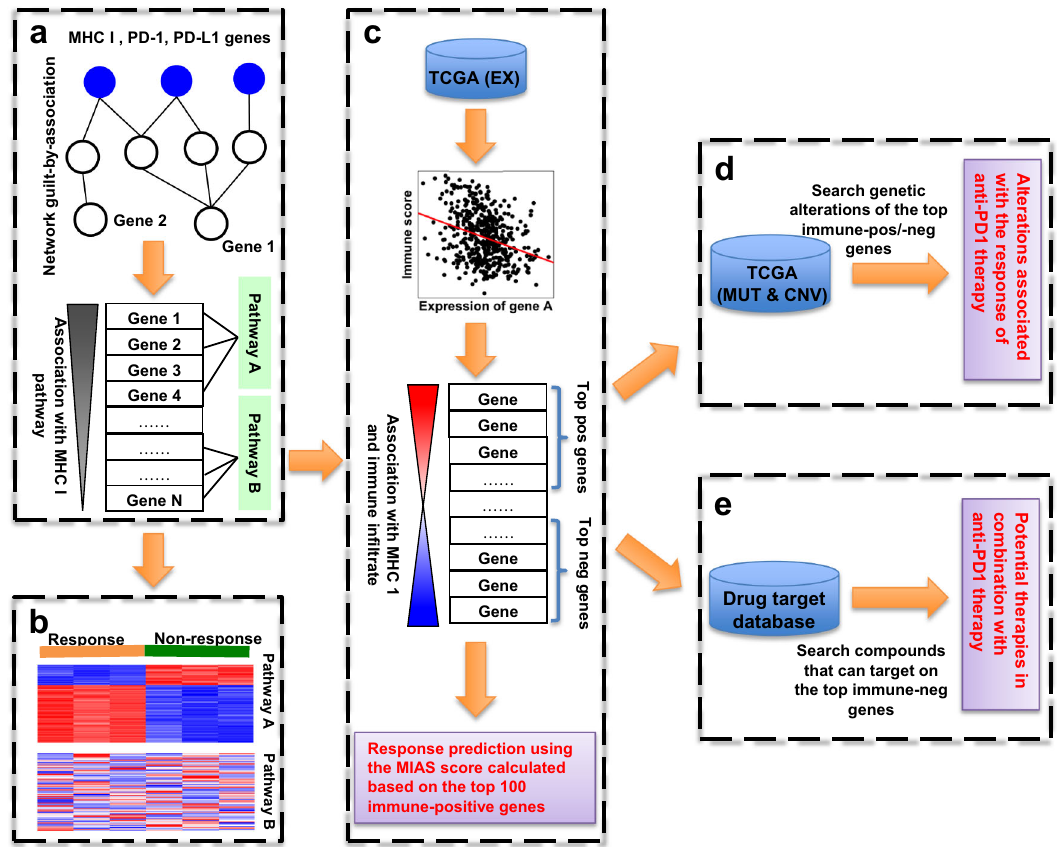
Fig. 1 Network-based approach. a Calculation of the functional association score of each gene with MHC I genes (blue node). Genes (e.g., gene 1) that are more functionally associated with the MHC I genes are assumed to be more associated with anti-PD-1 response than other genes (e.g., gene 2) are. Gene set enrichment analysis (GSEA) was used to identify pathways associated with response to anti-PD-1 therapy on the basis of an ordered gene list ranked by the association scores. Pathway A, which enriches genes with higher association scores, is more associated with anti-PD-1 therapy than is pathway B. b Gene expression data from tumor samples that were responsive and resistant to anti-PD-1 therapy are leveraged to identify pathways associated with anti-PD-1 therapy response for a speci fi c cancer type or cellular condition. c Integration of top genes (e.g., top 10%) in our association predictions (as described in a ) with the immune correlation of genes (calculated from TCGA transcriptomic data) to select the top immune-positive and -negative genes associated with tumor response to anti-PD-1 therapy in each cancer type. Among them, 100 top immune-positive genes are selected as the signature to predict patient response to anti-PD-1 therapy for a given cancer type. d Identi fi cation of genomic alterations that would be associated with response to anti- PD-1 therapy in a cancer type by integrating genomic alteration data of a TCGA cancer type with the top immune-positive and -negative genes described in ( c ). e Mapping drug target data to the top immune-negative genes (as described in c ) to identify compounds that can potentially boost response to anti- PD-1 therapy in a speci fi c cancer type. EX gene expression, MUT mutation, CNV copy-number